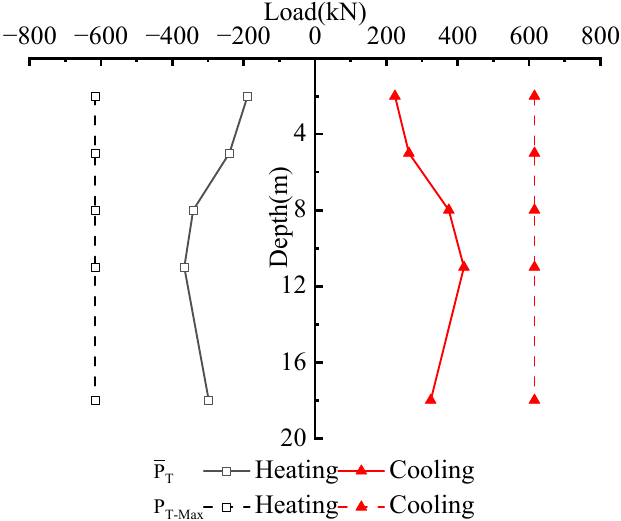
Figure 11. The distribution law of temperature-additional load along